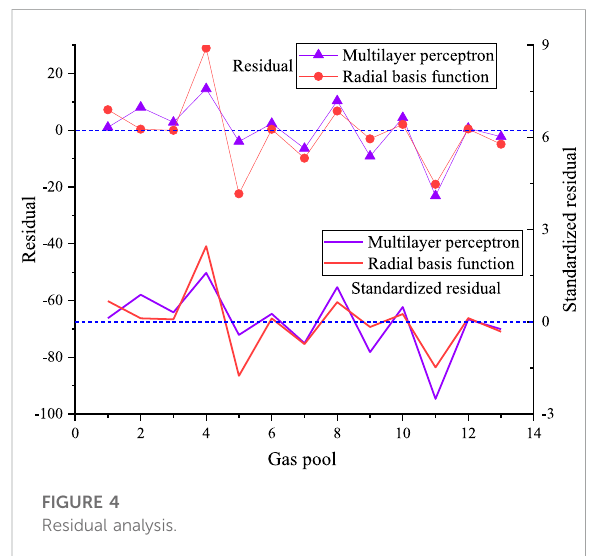
FIGURE 4 Residual analysis.